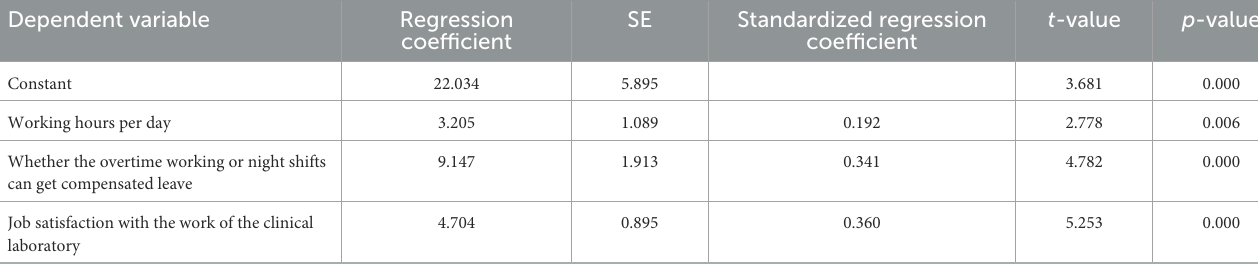
TABLE 4 Multiple-factor analysis of the job stress of Medical staff working in the clinical